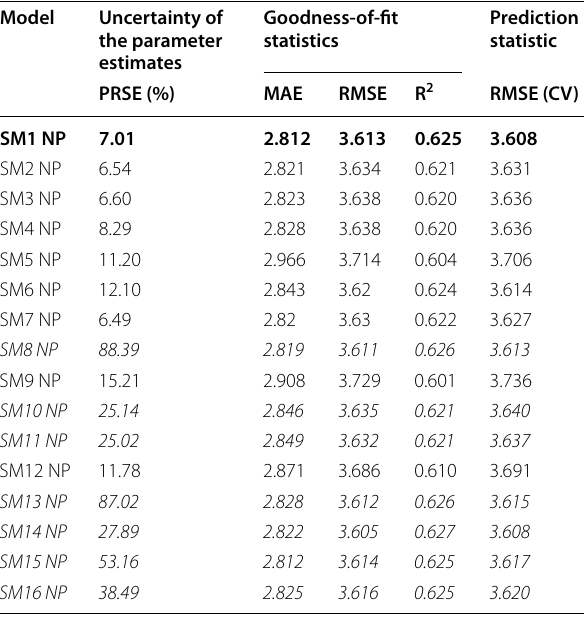
Bold, selected model. Italic, models with PRSE > 25%